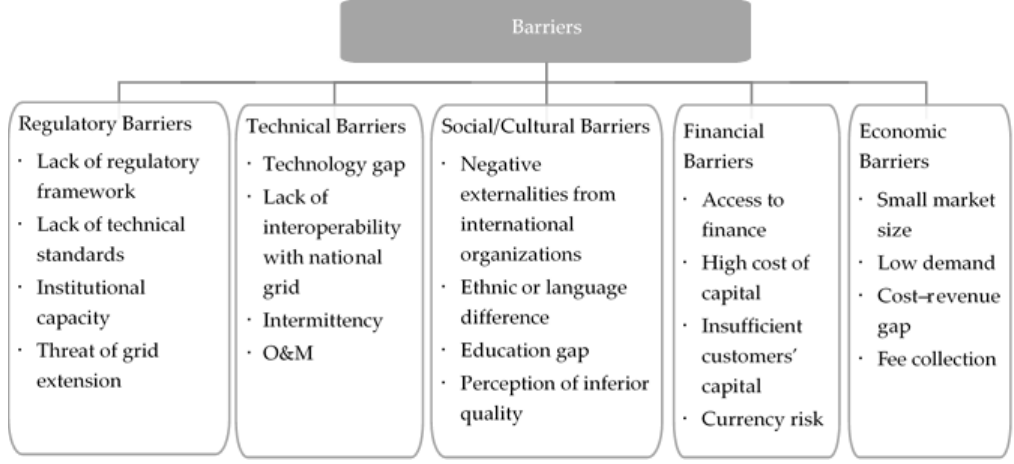
Figure 1. Hierarchized barriers. O&M: Operation and maintenance.